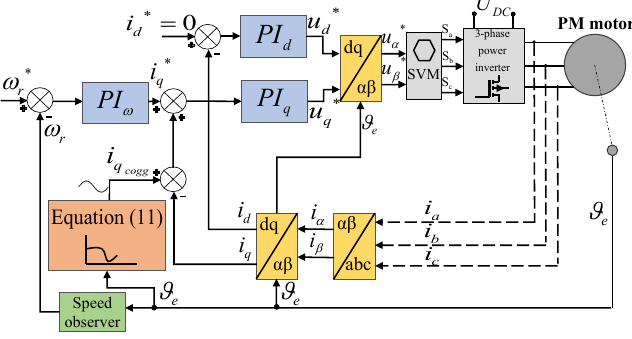
Figure 9. Proposed modification of